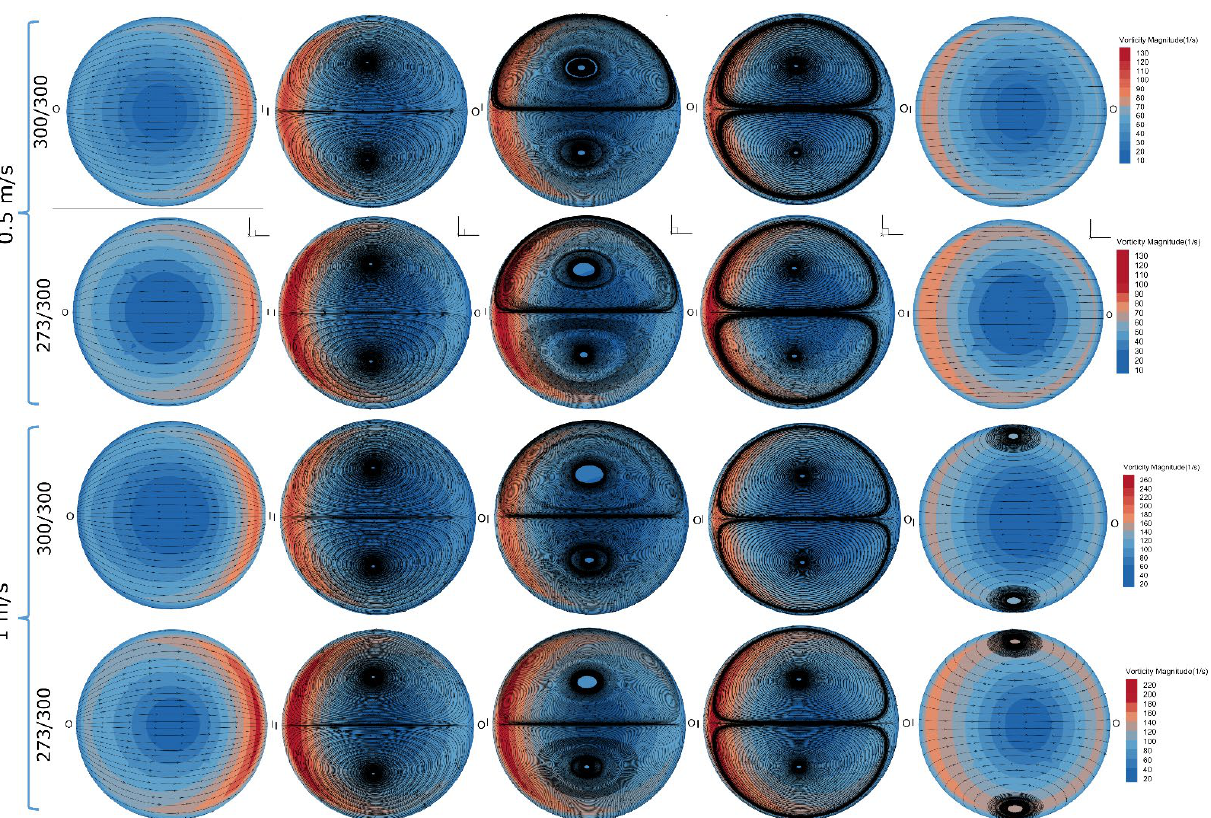
Figure 8. The vorticity magnitude and the projected streamlines at the five sections of the U-shaped channel. The first row shows the data at the inlet velocity of 0.5 m/s with no temperature difference. The second row shows the results at the inlet velocity of 0.5 m/s but at the temperature conditions of 273 K on the wall and 300 K of the incoming fluid at the inlet. The third row shows the results at the inlet velocity of 1 m/s with no temperature difference. The fourth row shows the results at the inlet velocity of 1 m/s but at the temperature conditions of 273 K on the wall and 300 K of the incoming fluid at the inlet.